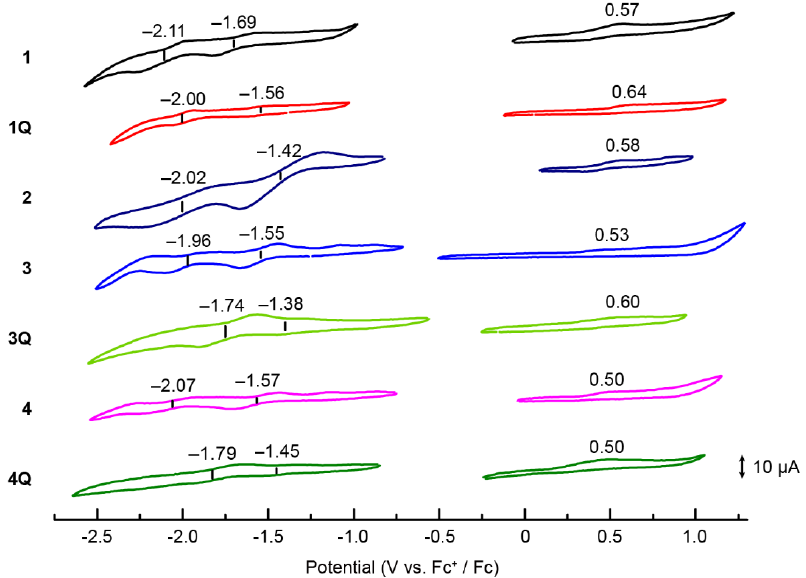
Figure 5. Cyclic voltammograms of 1 (black), 1Q (red), 2 (purple), 3 (blue), 3Q (light green), 4 (pink), and 4Q (green) recorded from 1.0 mM solutions of the analytes in [ n Bu 4 N]ClO 4 / o -DCB. Ferrocene was used as the internal standard, and the Fc/Fc + couple was set to 0 V.